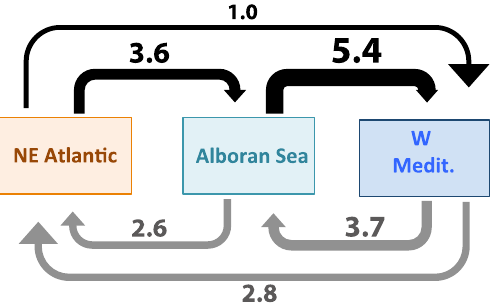
Figure 6. Migration across the Alboran Sea in C. tenuispina . Immigration rates estimated with the software Migrate. Gene flow from west to east represented with black arrows, and from east to west with grey arrows.